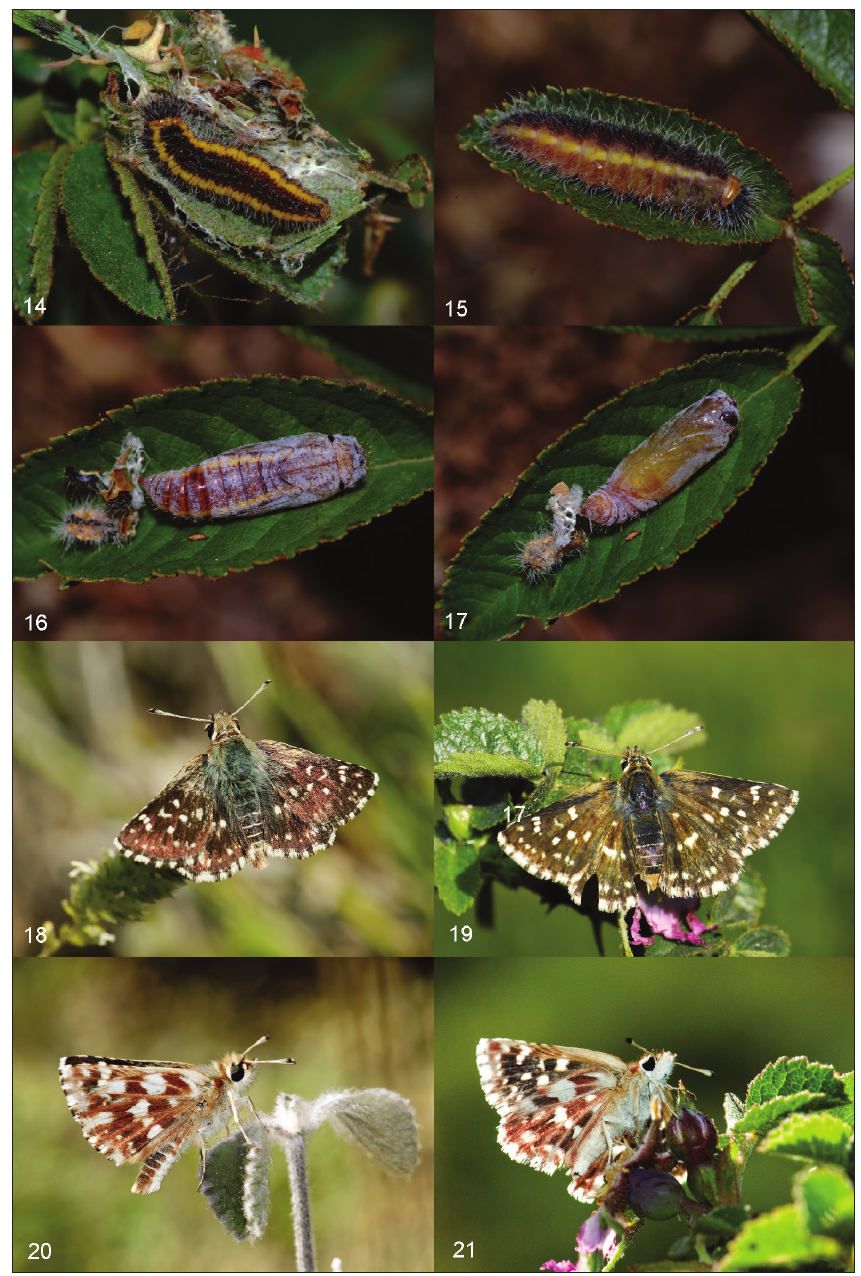
Figures 14–21. Life cycle of Spialia rosae . 14. Dorsal view of a last instar larva on Rosa sicula in Puerto de la Ragua, Granada, SE Spain (July 2012). 15. Pre-pupa on R. sicula in Puerto de El Cubillo, Cuenca, Central Spain (August 2012). 16, 17. Dorsal and lateral views of a pupa on R. sicula in Puerto de El Cubillo (Septem- ber 2012). 18, 19. Upperside views of adult male and female in Puerto de la Ragua (July 2013). 20, 21 . Side view of adult male and female in Puerto de la Ragua (July